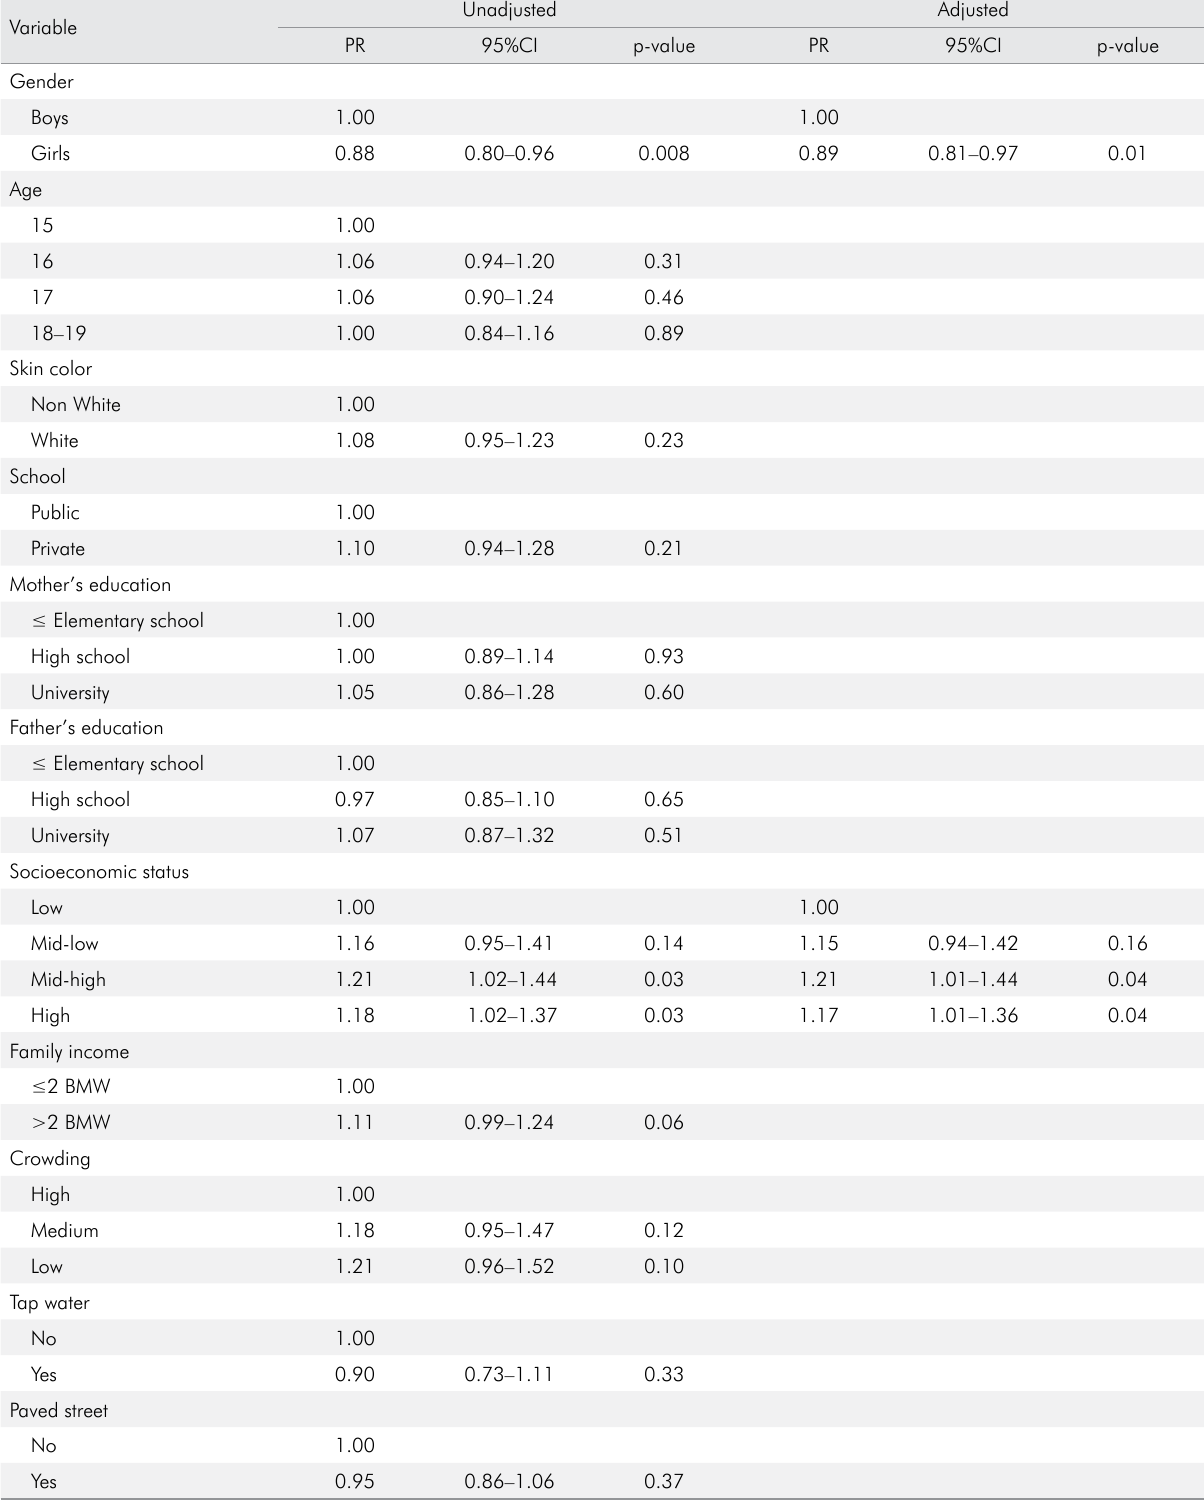
Table 2. Association between explanatory variables and ETW prevalence. Unadjusted and adjusted Poisson regression analyses. Santa Maria, Brazil, 2018 (n =